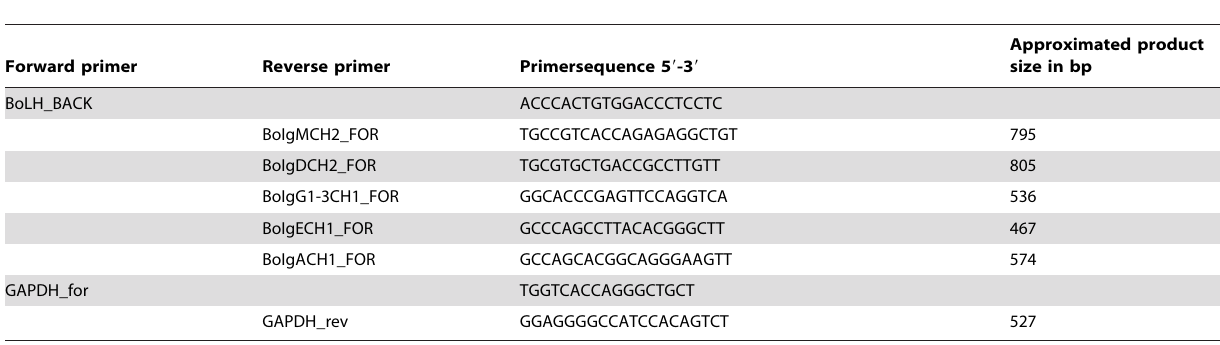
Table 1. Primer for the isotype-specific amplification of the complete variable